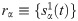
Snapshot of the arm-posture task and directions of X-, Y- and Z-axes in the Cartesian coordinate system.Green dots represent the location of the attached markers: (a) the end of the rod rα≡{sα1(t)}, (b) the finger fα≡{sα2(t)}, (c) the wrist wα≡{sα3(t)}, (d) the elbow eα≡{sα4(t)}, and (e) the shoulder sα≡{sα5(t)}. The dot (f) indicates the location of the target.